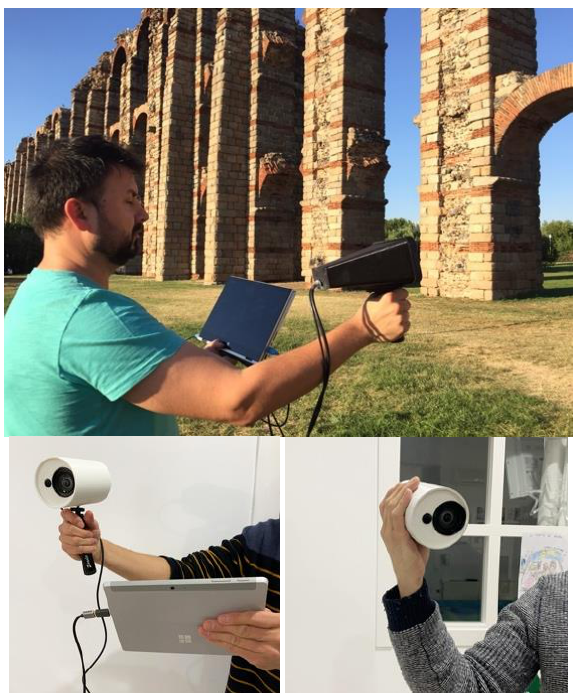
Figure 1 . Evolution of the design of the prototypes. First prototype while scanning the Roman aqueduct of "Los Milagros" (above). Last version of the prototype optimising the design and ergonomics by carrying it on a handle (bottom left) and carrying it directly by hand (bottom right). Figure 2 . Refined image selection